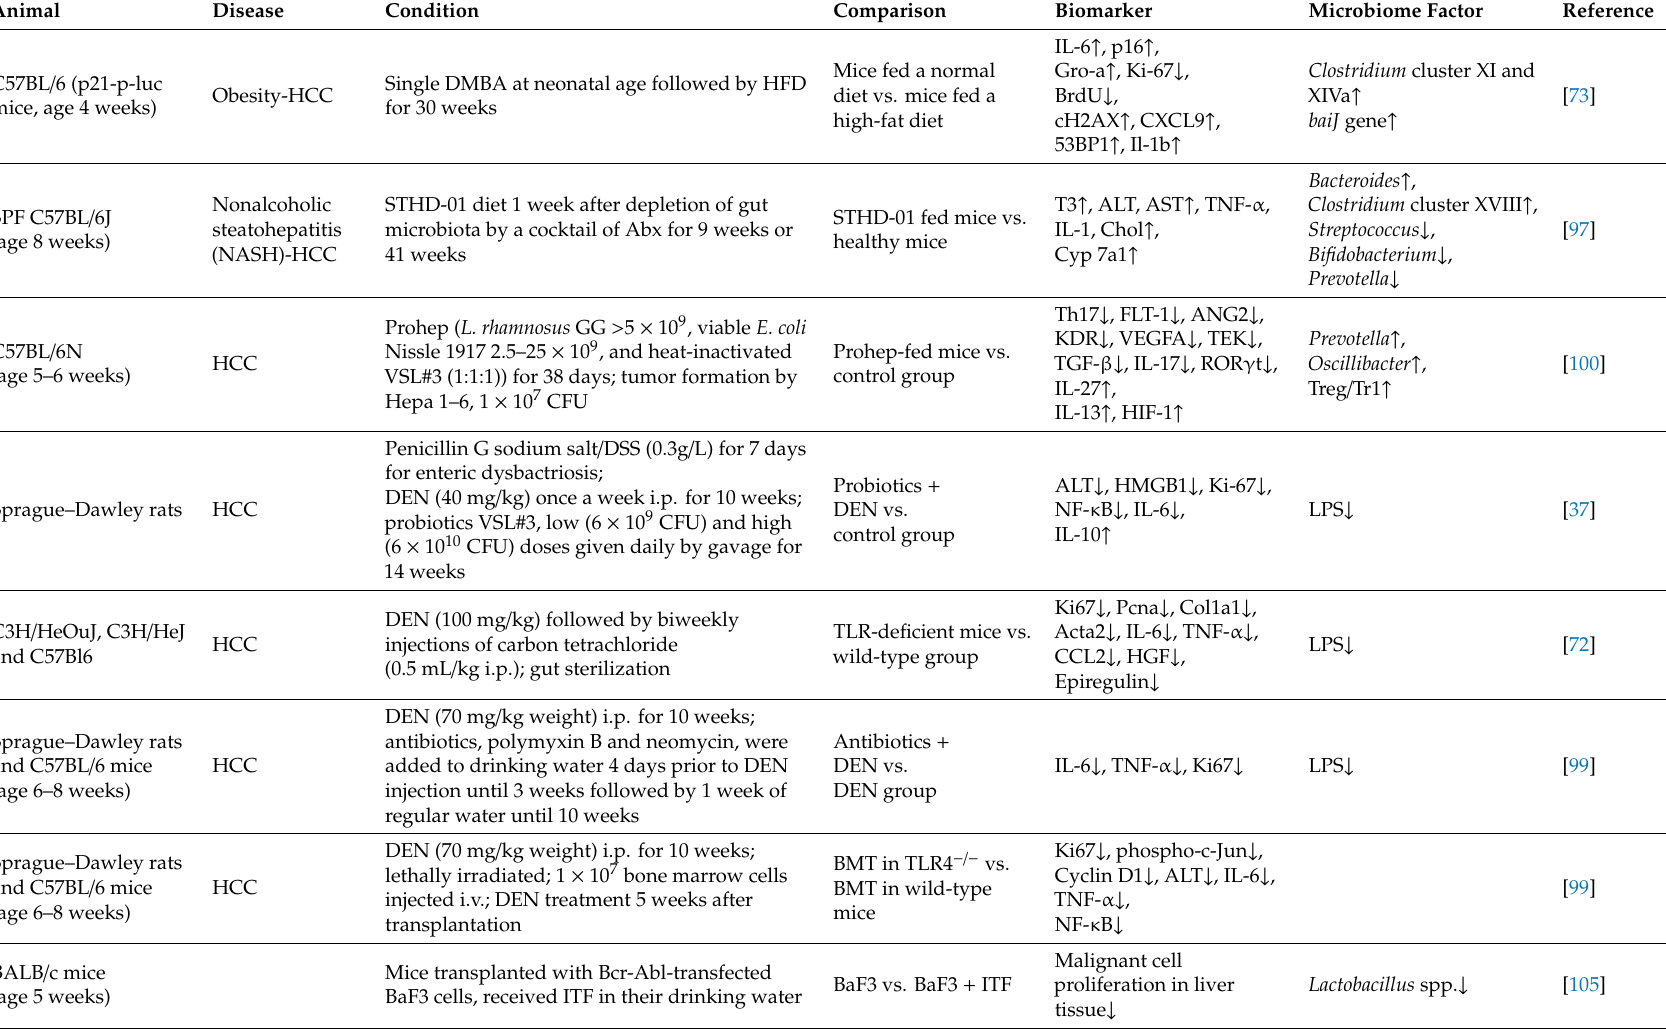
Table 1. Animal studies of the relation between the microbiome and hepatocellular carcinoma. Animal Disease Condition Comparison Biomarker Microbiome Factor